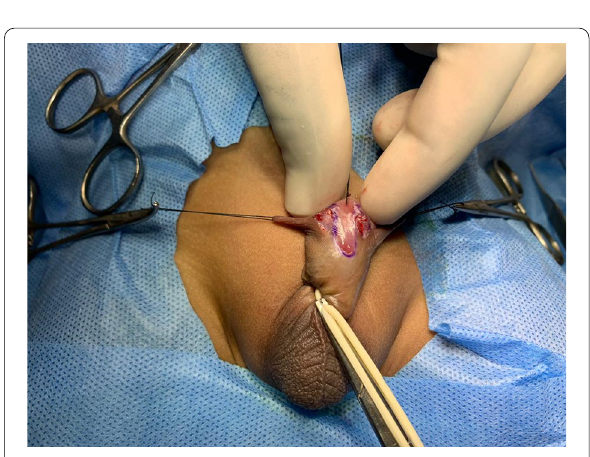
Fig. 2 Skin of the peri‑urethral triangles excised to allow future